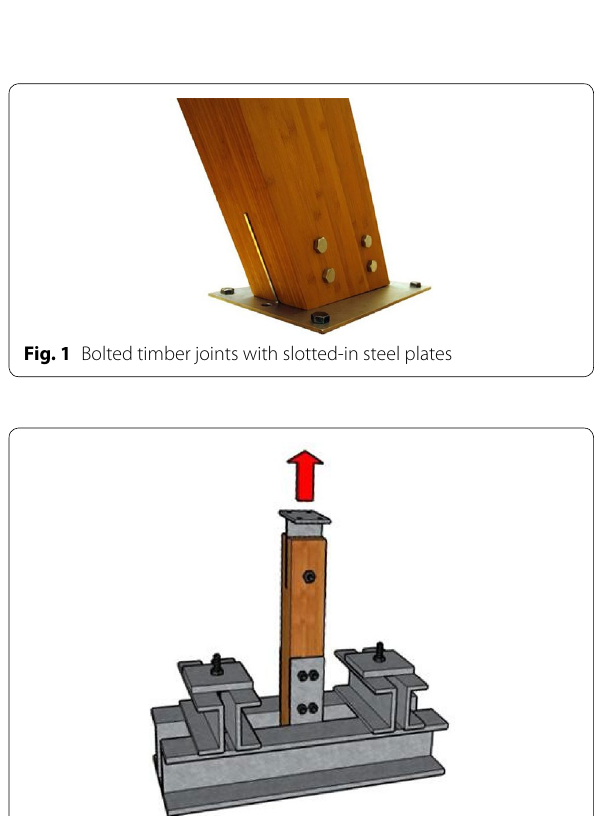
Fig. 2 Test schematic of the mechanical properties of the bolted timber joints with slotted-in steel plates parallel to the